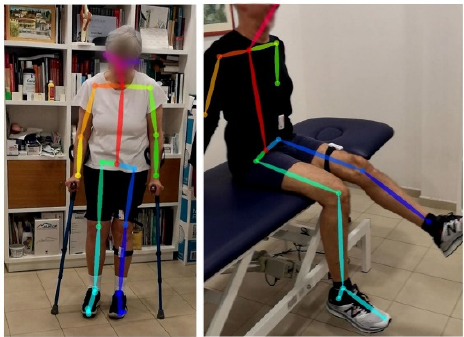
Figure 3. OpenPose video frame skeleton detection on a post-operative TKA ( left ) and THA ( right ).